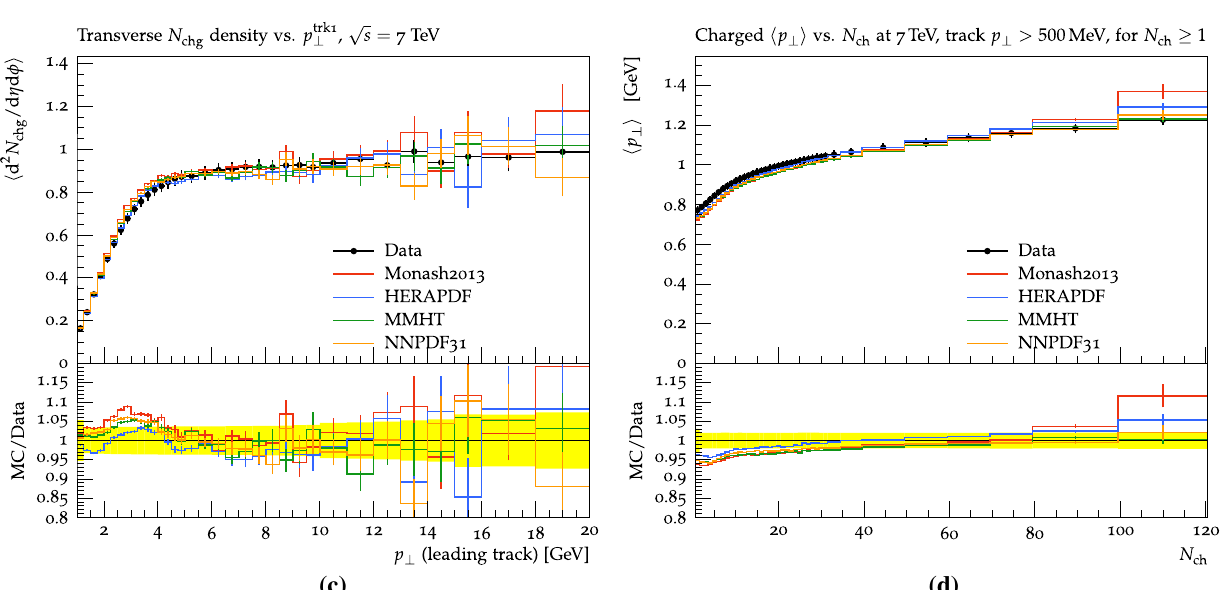
Fig. 3 A selection of distributions measuring the underlying event level at the LHC at 7TeV which were used in the tuning of variants of Monash 2013 with different PDF selection, described in the text. The differential number of charged tracks in pseudorapidity as mea- sured by CMS [51] is shown in a. The differential energy deposit at large rapidities as measured by CMS [52] is shown in b. The density of